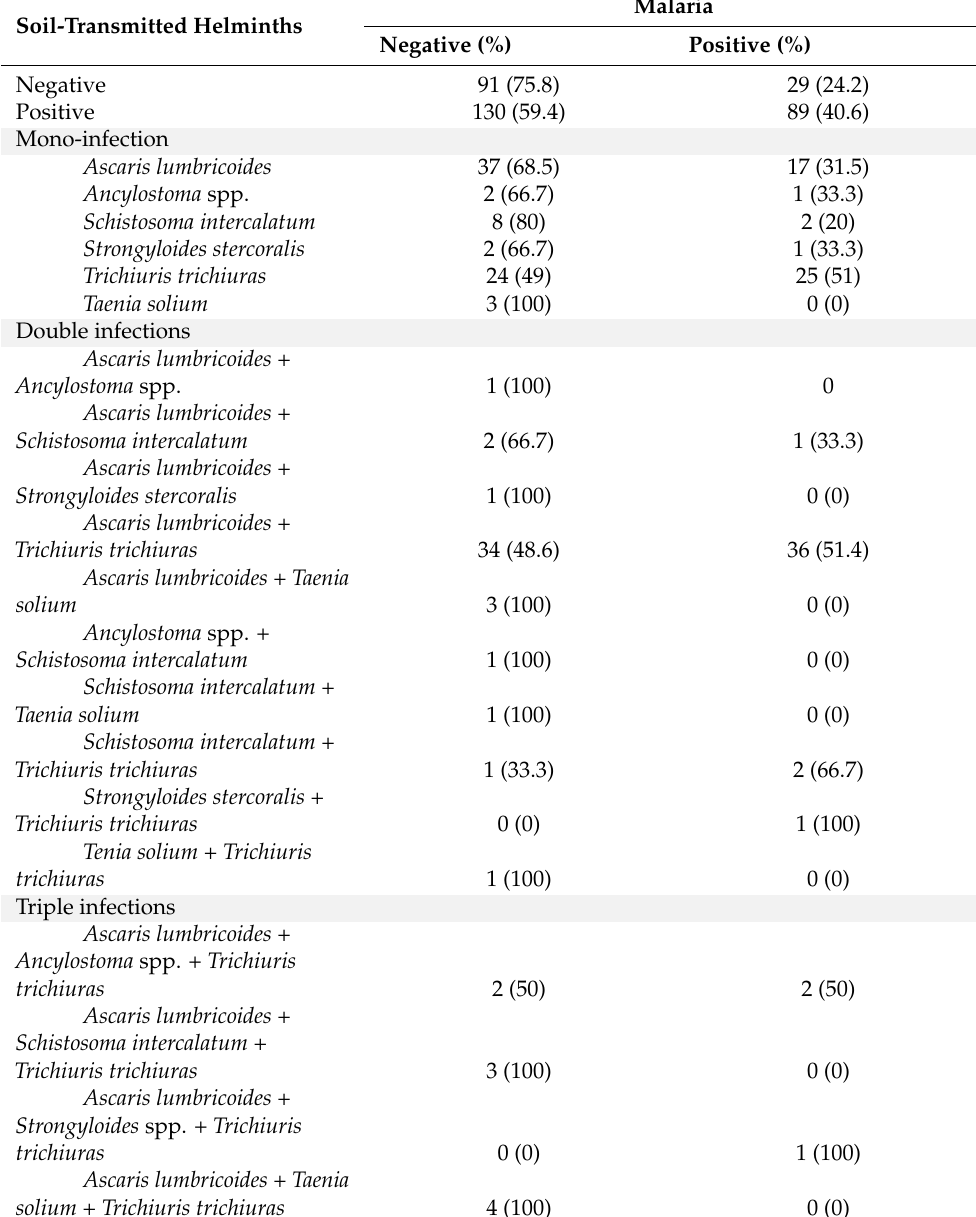
Table 4. Association between malaria and soil-transmitted